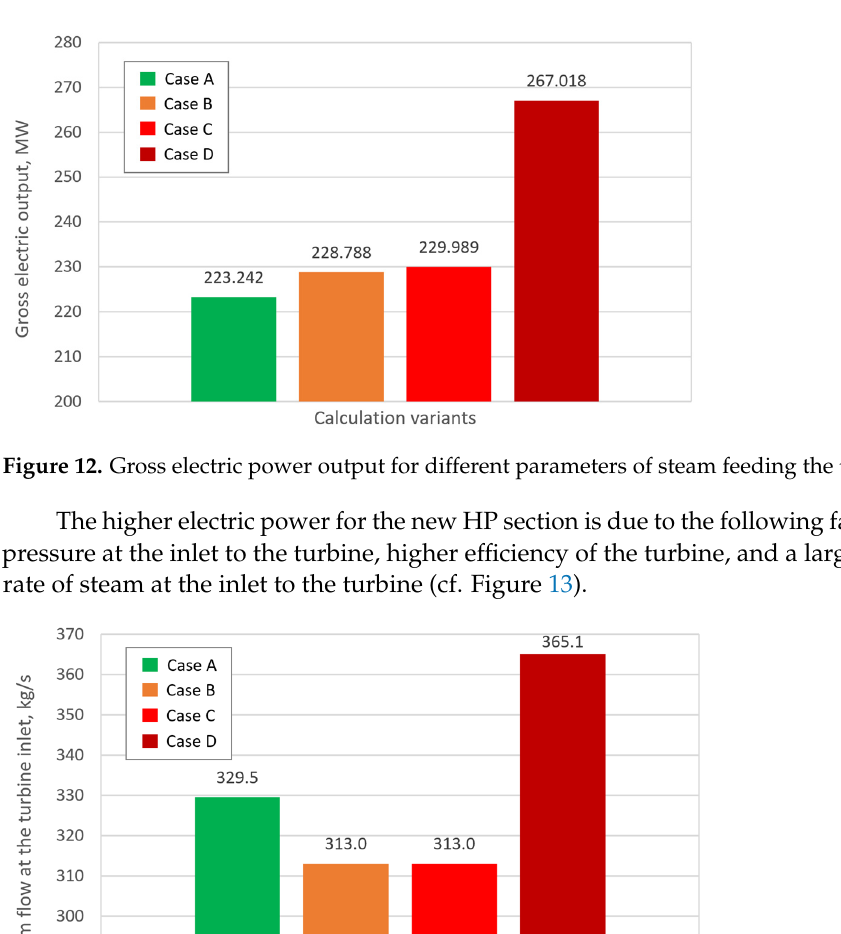
Figure 11. Heat rate for different parameters of steam feeding the turbine.